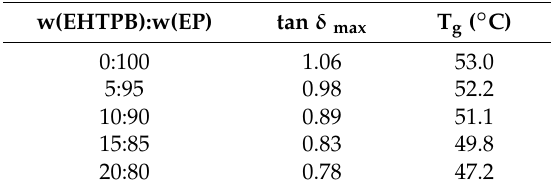
Table 3. DMA data of the epoxy resin with different w(EHTPB)/w(EP)